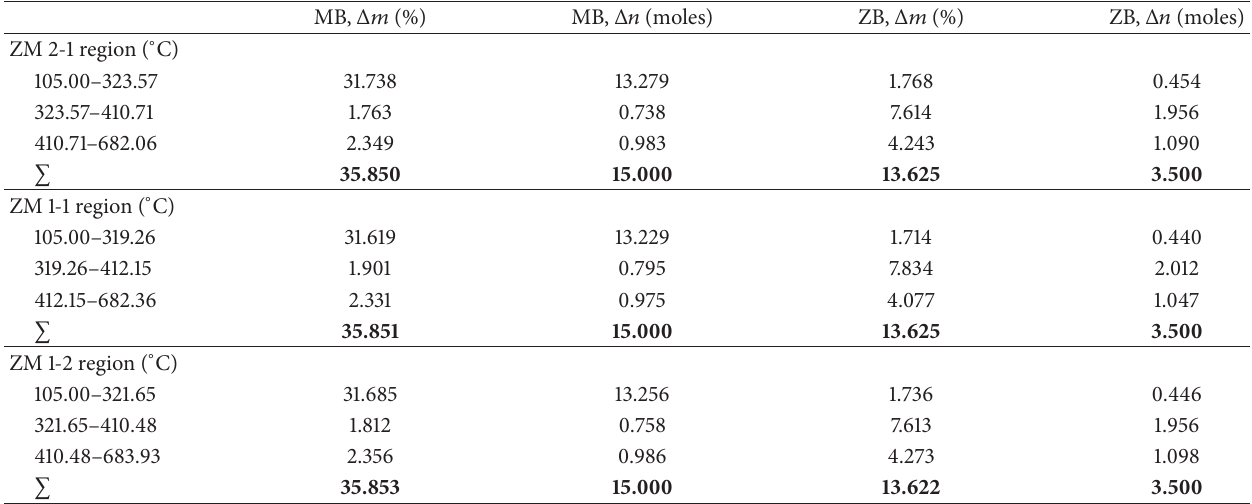
Table 8: The weight losses, both percentages and moles, of the pure zinc and magnesium borates at the endothermic